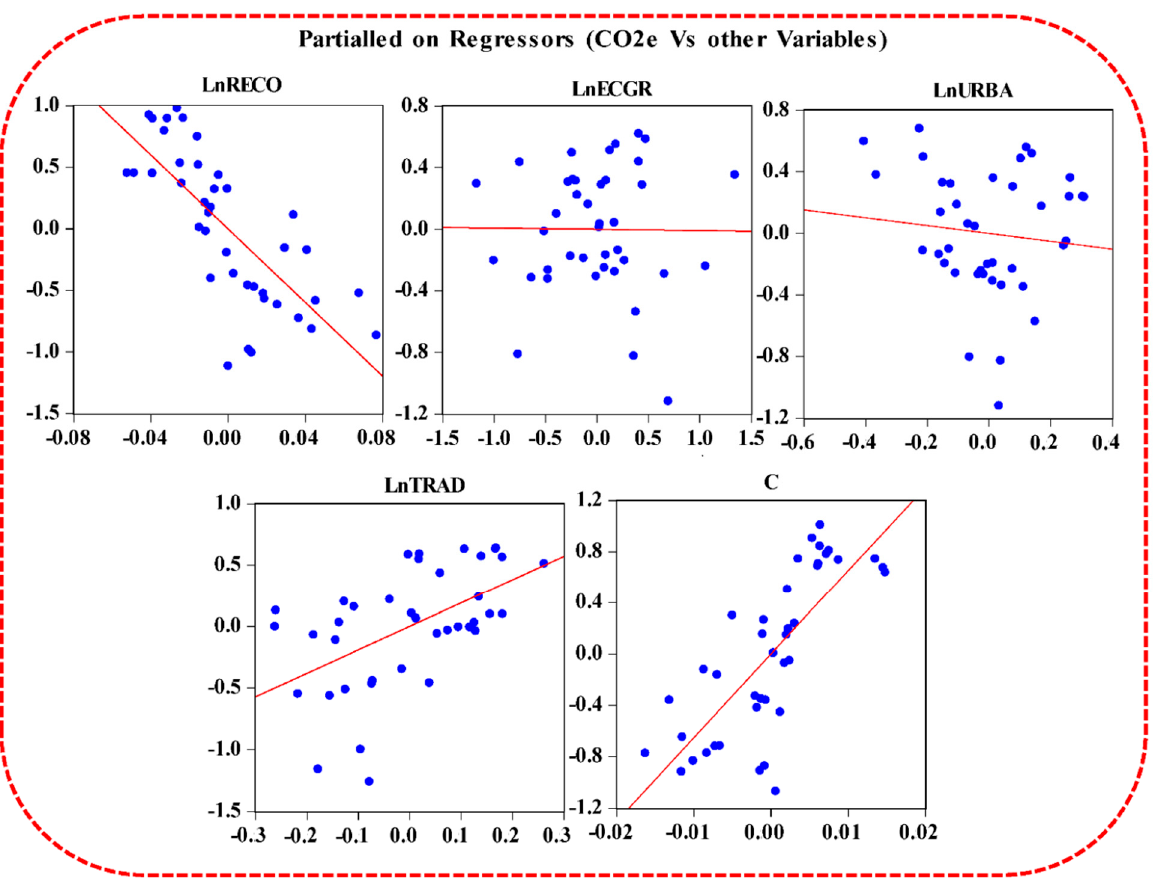
Figure 3. Partial regression leverage plots.